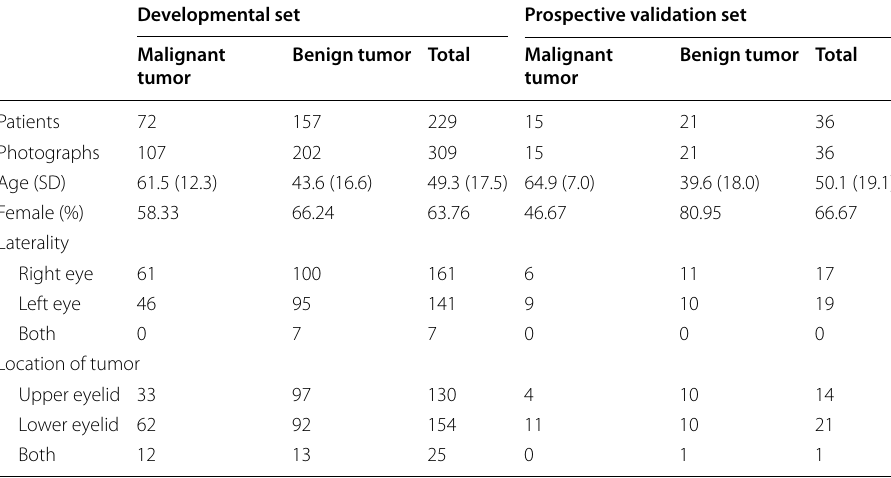
SD standard deviation